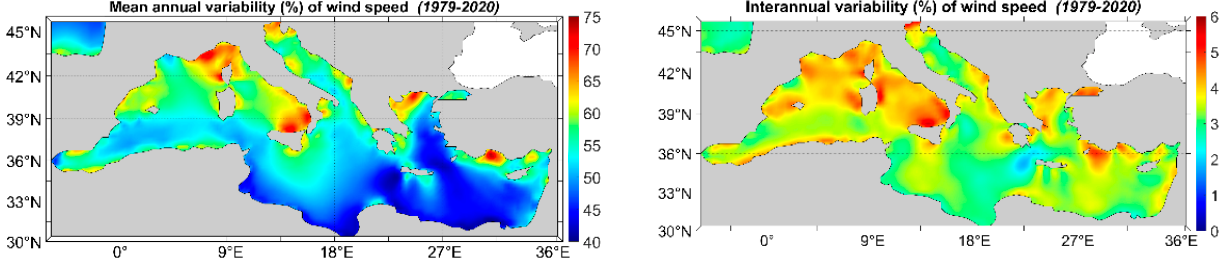
Figure 4. Mean annual ( left ) and interannual ( right ) variability of wind speed. The right plot of Figure 4 illustrates the spatial distribution of the IAV . Again, the interannual variability exhibits lower values in the southern part of the basin (except for the coasts of Algeria). The largest value (6%) appears in the S Tyrrhenian sub-basin and the N Levantine Basin. The regions with the overall largest IAV are the Balearic, the Ligurian and the Tyrrhenian Seas, as well as the N Aegean and the S coasts of Turkey. The lowest value of IAV appears off the W coasts of Crete Isl. Note that the results based on ERA-Interim [35] demonstrate higher maximum values of IAV (7.25%), appearing in the W Ligurian Sea. Figure 5 depicts the angular variance of the mean annual wind direction. The angular variance is a measure of the spread of the mean annual wind direction values around the overall annual mean. The smaller the angular variance, the more concentrated the circular distribution. The majority of the Mediterranean areas presents values close to 0 (0–0.02) with a few specific areas with values above 0.03. This result suggests that the mean annual wind direction remains, to a large extent, stable. The regions that exhibit the highest angular variance are found in the western part of the Mediterranean Sea and are very localized, e.g., the middle of the Alboran Sea, the W Algerian basin, the Balearic Sea (around and especially north of Mallorca) and the N Ligurian Sea (off the coasts of Monaco and offshore the Gulf of Genoa). Values of angular variance close to 1 suggest that the mean annual wind direction is highly variable. Lower values around 0.4 appear as well in specific spots in the Adriatic Sea and the Gulf of Mersin. These results are in general similar to the results by Soukissian [35], in terms of the areas that present the highest values, however, the more sophisticated the ERA5 dataset indicates that there are more areas with high values